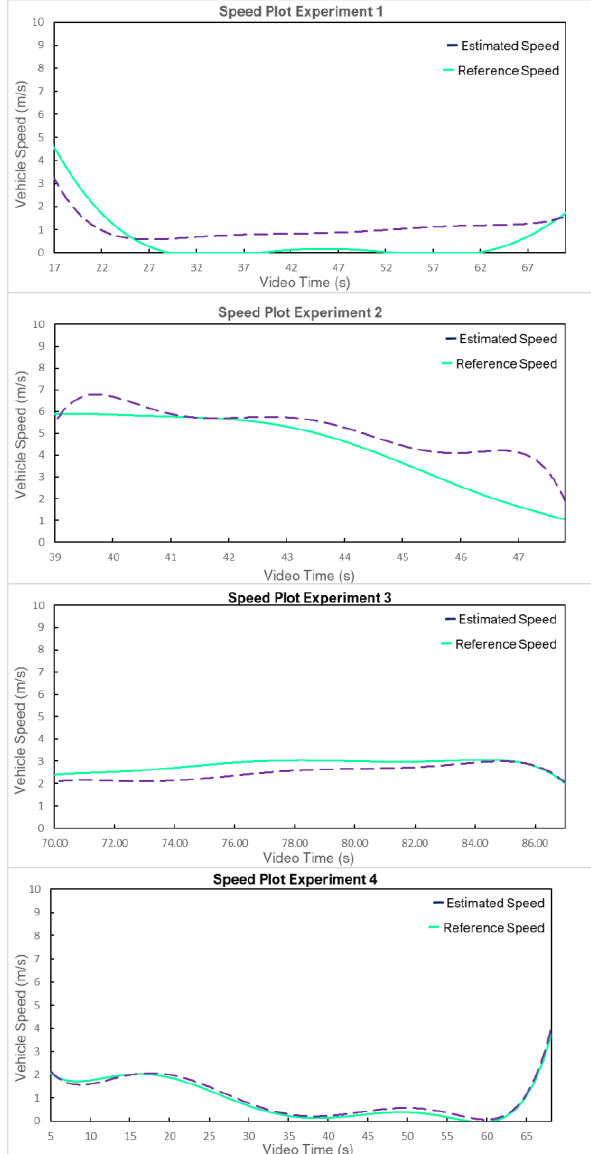
Figure 7. DSLR Speed Estimation